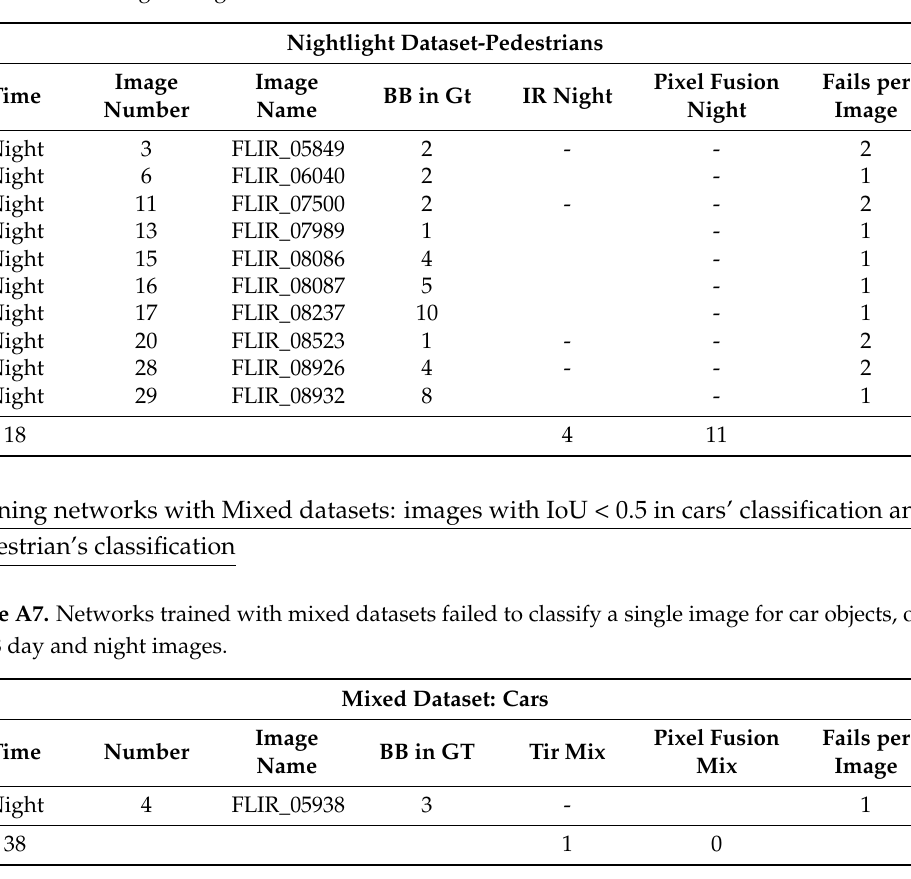
Table A6. Networks trained with night image datasets failed to classify 4–11 images for pedestrian objects out of 18 night images.